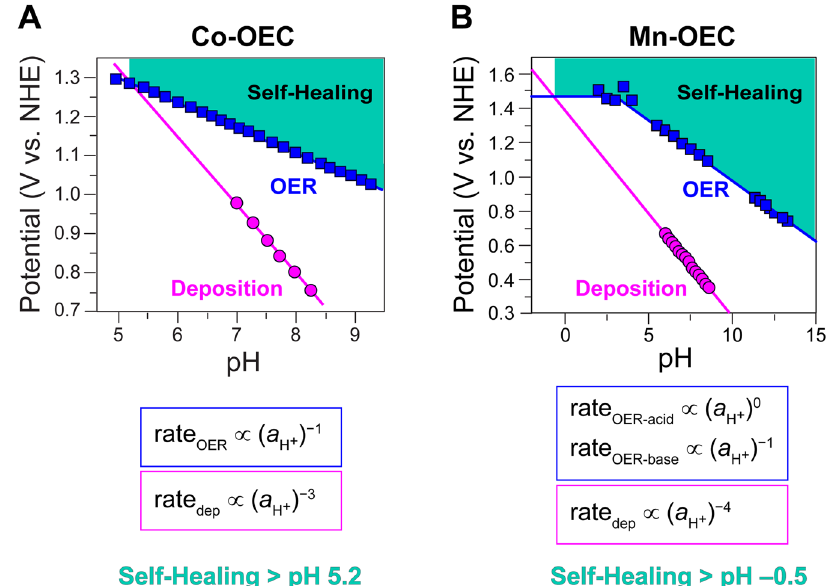
Fig. 3 Pourbaix diagrams for Co- and Mn-OECs. Potential – pH diagrams for ( A ) Co-OECs and ( B ) Mn-OECs at fi xed current densities of j = 30 and 1.3 μ A cm − 2 (based on geometric electrode surface area), respectively. The dependence of the rate of OER and the rate of catalyst deposition/regeneration on proton activity ( a H + ) are highlighted in blue and magenta, respectively, for each catalyst type. The different pH dependence for the two processes forms the foundation for the self-healing properties of Co-OECs and Mn-OECs above pH 5.2 and − 0.5, respectively, in solutions devoid of component metals as indicated with the teal zones in the graphs. All potentials are referenced to the NHE